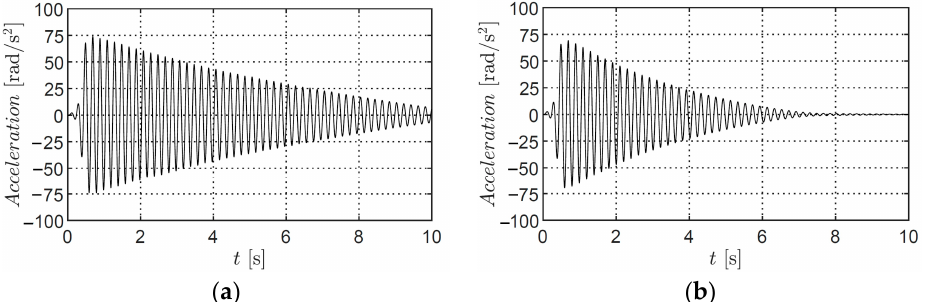
Figure 13. Filtered response of SDOF pitch response: ( a ) filtered acceleration time history at U = 0 m/s; ( b ) filtered acceleration time history at U = 10 m/s.